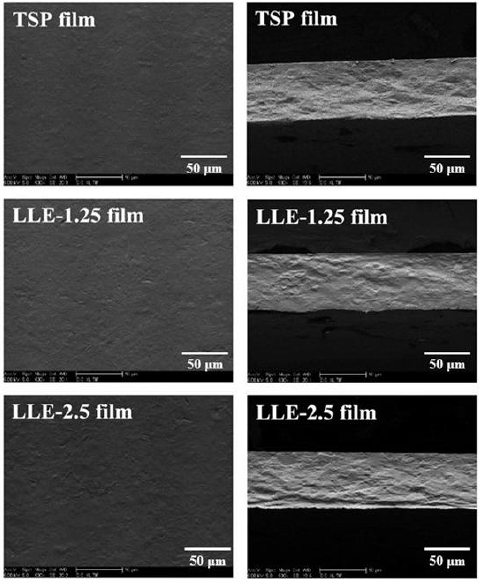
Figure 3. SEM of the TSP film and pH-sensing film (LLE-2.5). Left micrograph shows the surface